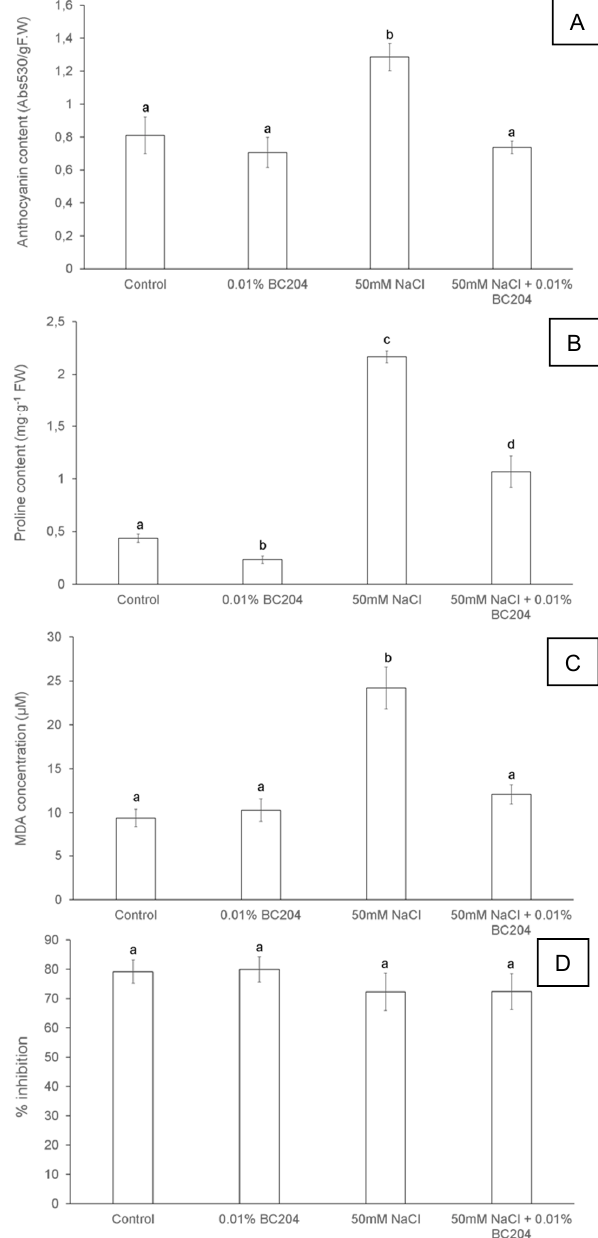
Figure 6. Anthocyanin content (A), proline content (B), malondialdehyde concentration (C) and % SOD inhibition (D) in Arabidopsis thaliana shoot tissue following BC204 and NaCl treatment. Bars represent the mean of 9 replicates (n=9) ± standard error. Different letters indicate values that were determined by one-way ANOVA with Fisher’s LSD post-hoc test to be significantly different (P<0.05) from the control.